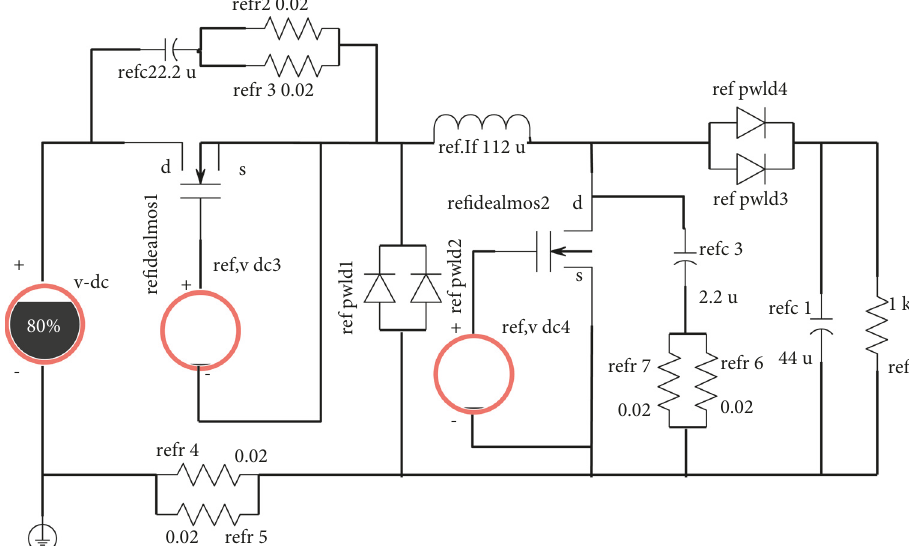
Figure 5: Simulation diagram of the main circuit of the double-tube buck-boost power conversion in the pass-through